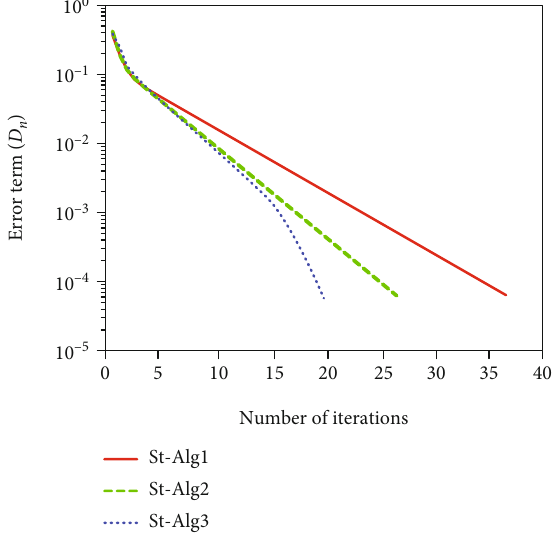
Figure 5: Numerical computational behavior of Algorithm 1:, Algorithm 2:, and Algorithm (4.2) while κ 0 = κ 1 = ð 2 t 3 − 3 e t Þ cos ð t Þ